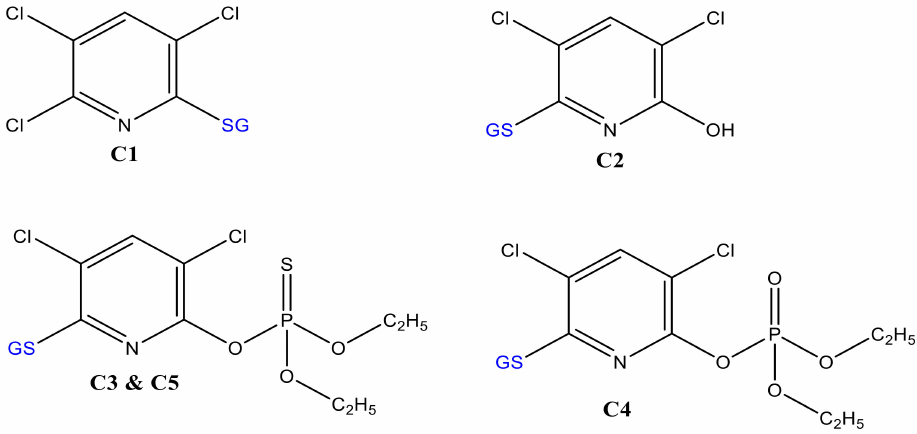
Figure 4. Proposed molecular structures of GSH-conjugates with CPF oxidative